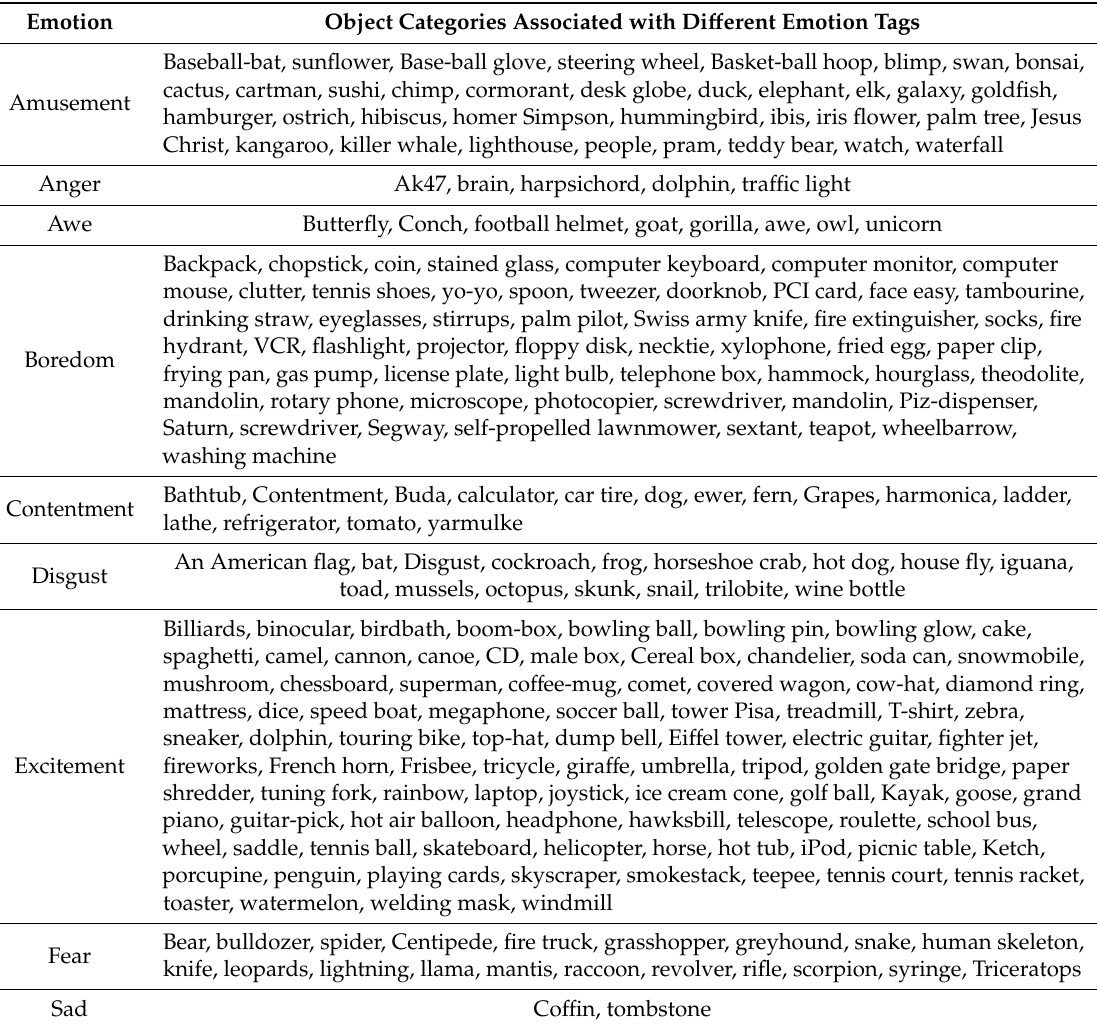
Table 1. Subjective labeling of bottom-level object categories with their respective emotions